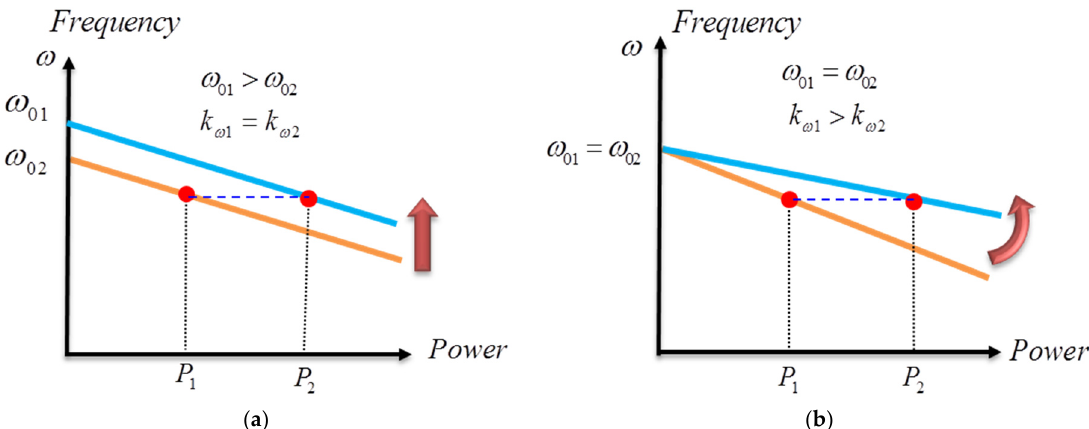
Figure 1. Two ways of real power regulation using frequency droop: ( a ) changing nominal frequency where frequency droop gain is fixed; and ( b ) changing frequency droop gain while keeping nominal frequency fixed.